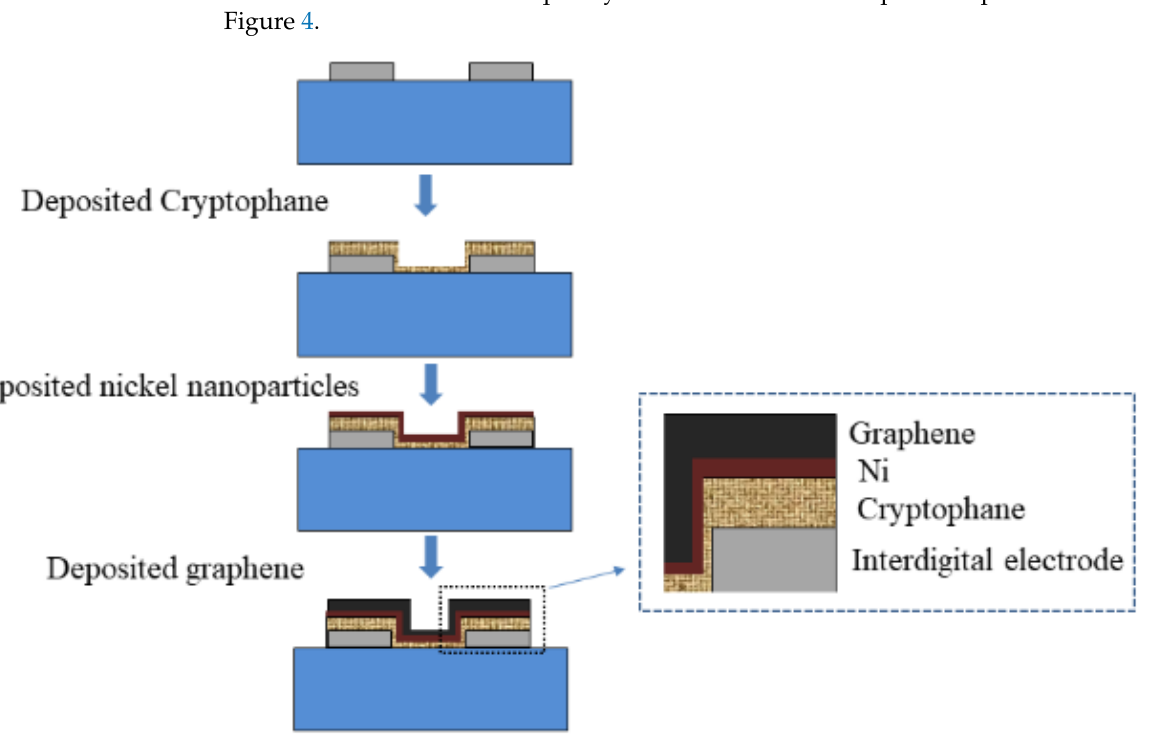
Figure 4. Sensitive film deposition process.